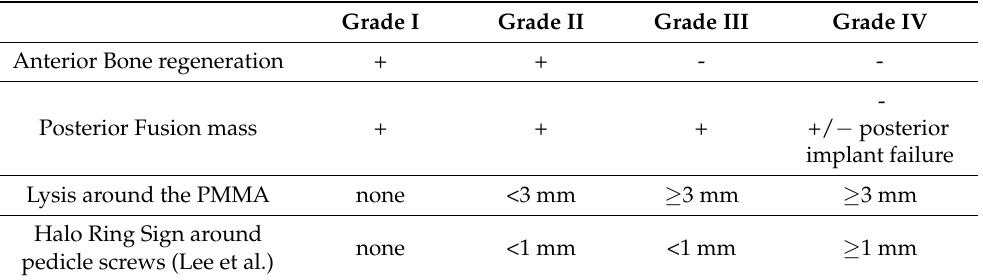
Table 2. New developed grading to evaluate bone regeneration, posterior fusion, and implant stability based on Lee et al., Bridwell et al. and Gruen et al. [12–14]. The halo sign is detectable, especially in anterior–posterior X-rays as lysis around a pedicle screw, suggestive of implant